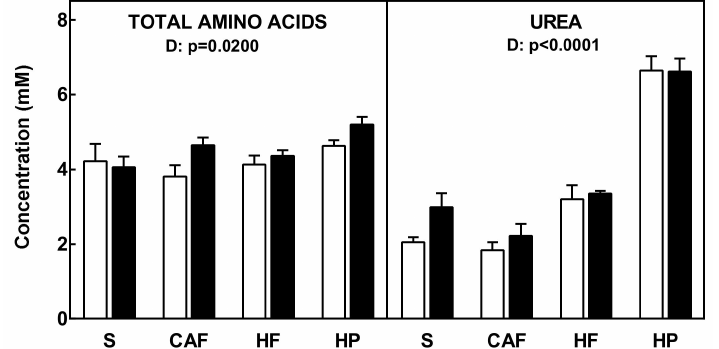
Figure 1. Plasma total amino acids and urea levels of female and male rats fed a standard, cafeteria, high-fat, or high-protein diet for 30 days. The data correspond to the mean ± SEM of 6–8 different animals. Females are represented by white bars, and males by black. Abbreviations: S is standard diet, CAF is cafeteria diet, HF is high-fat diet, and HP is high-protein diet. Statistical analysis was done using a two-way ANOVA program for diet (D) and sex (S). Only significant values are